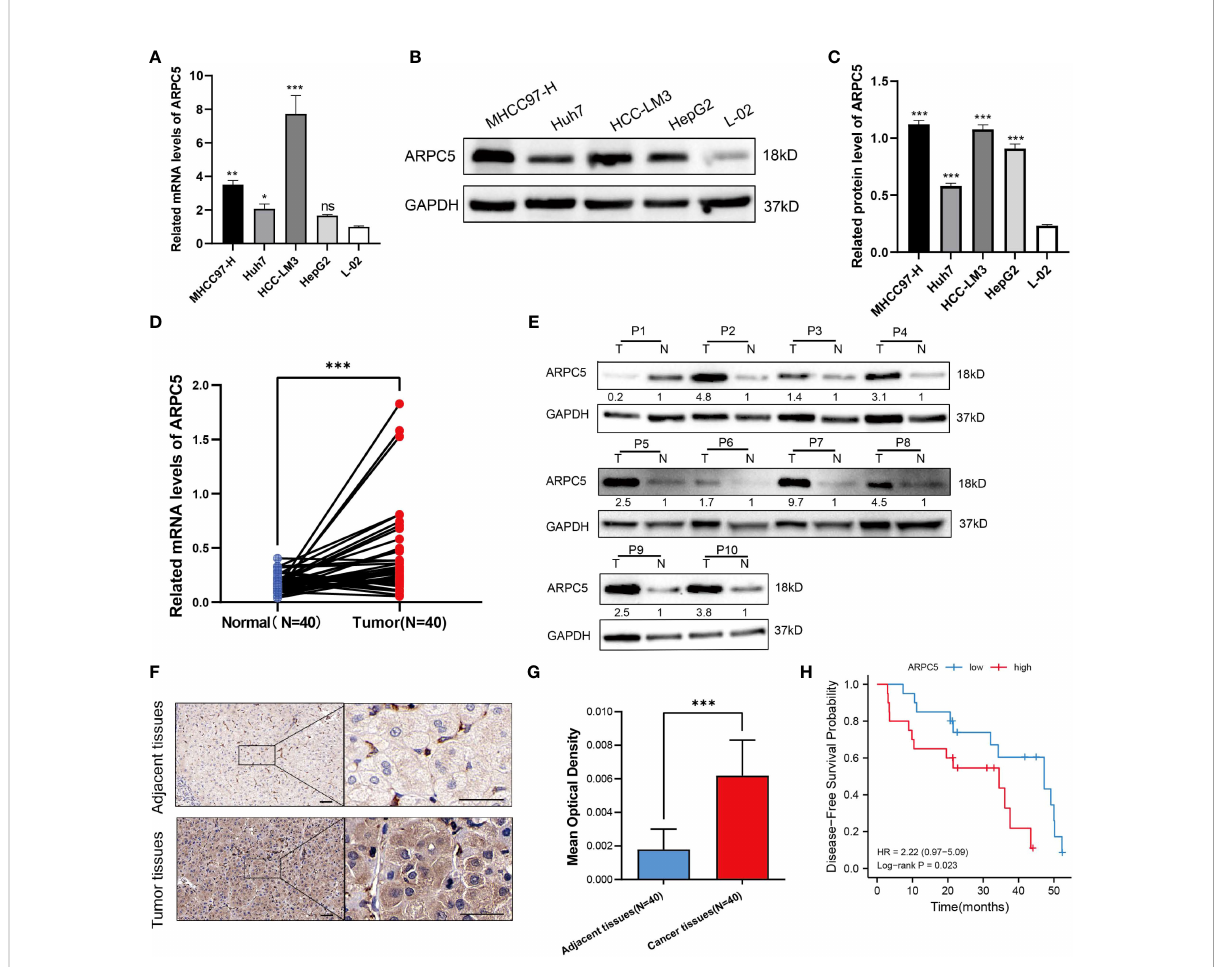
FIGURE 10 ARPC5 is upregulated in HCC cells and primary HCC tissues. (A) qPCR analysis of ARPC5 mRNA expression in four HCC cell lines (MHCC97-H, Huh7, HCC-LM3, and HepG2) and normal liver cell line (LO2). GAPDH was used as an internal control error bars represent M ± SEM (triplicate experiments). (B, C) The protein expression of ARPC5 was detected in four HCC cell lines and normal liver cell line with Western blot analysis. Error bars represent M ± SD of triplicate measurements. (D) The mRNA expression of ARPC5 in 40 pairs HCC tissues and adjacent para- carcinoma tissues was evaluated using qPCR. (E) Western blot analysis of ARPC5 protein expression in 10 paired HCC tissues and adjacent normal tissues. The number presented the relative protein expression levels of ARPC5. (F) Representative images of ARPC5 immunohistochemical staining analysis in the HCC tissue and adjacent normal liver tissue, original magni fi cations: ×40 and ×200. Scale bars, 50 m m. (G) Quantitative analysis of ARPC5 expression in HCC tissues based on mean optical density of immunohistochemical staining. Error bars represent the M ± SD of multiple tissues. (H) Kaplan – Meier curves showed that higher expression of ARPC5 was associated with poor DFS in HCC patients. * p < 0.05; ** p < 0.01; *** p < 0.001. ns, no signi fi